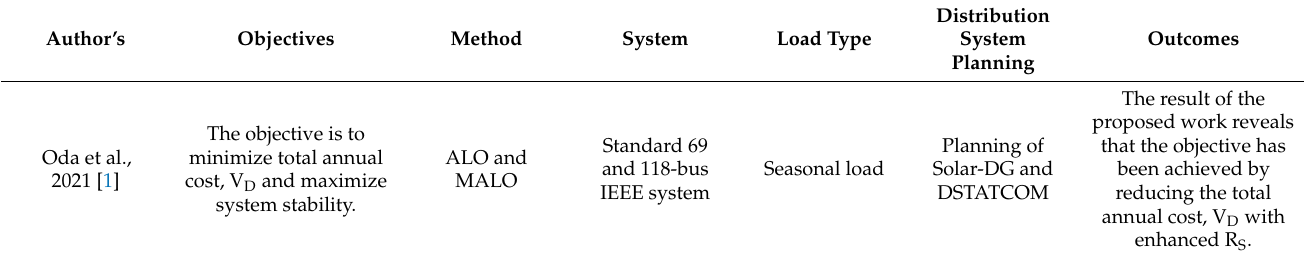
Table 1. Review on Distribution System Planning Methodology, Objectives, and